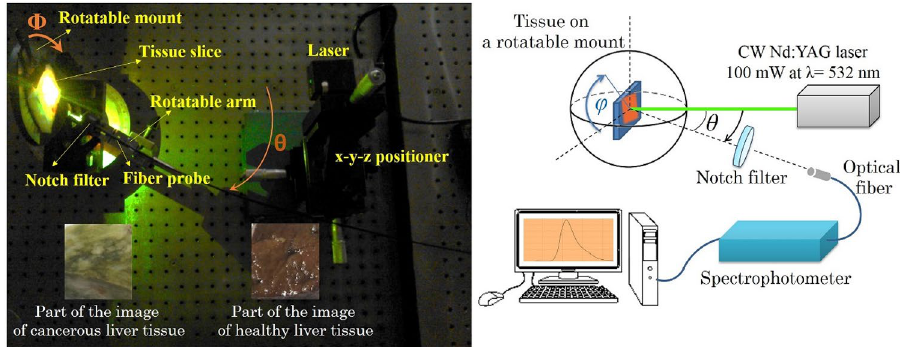
Figure 3. Angular measurement